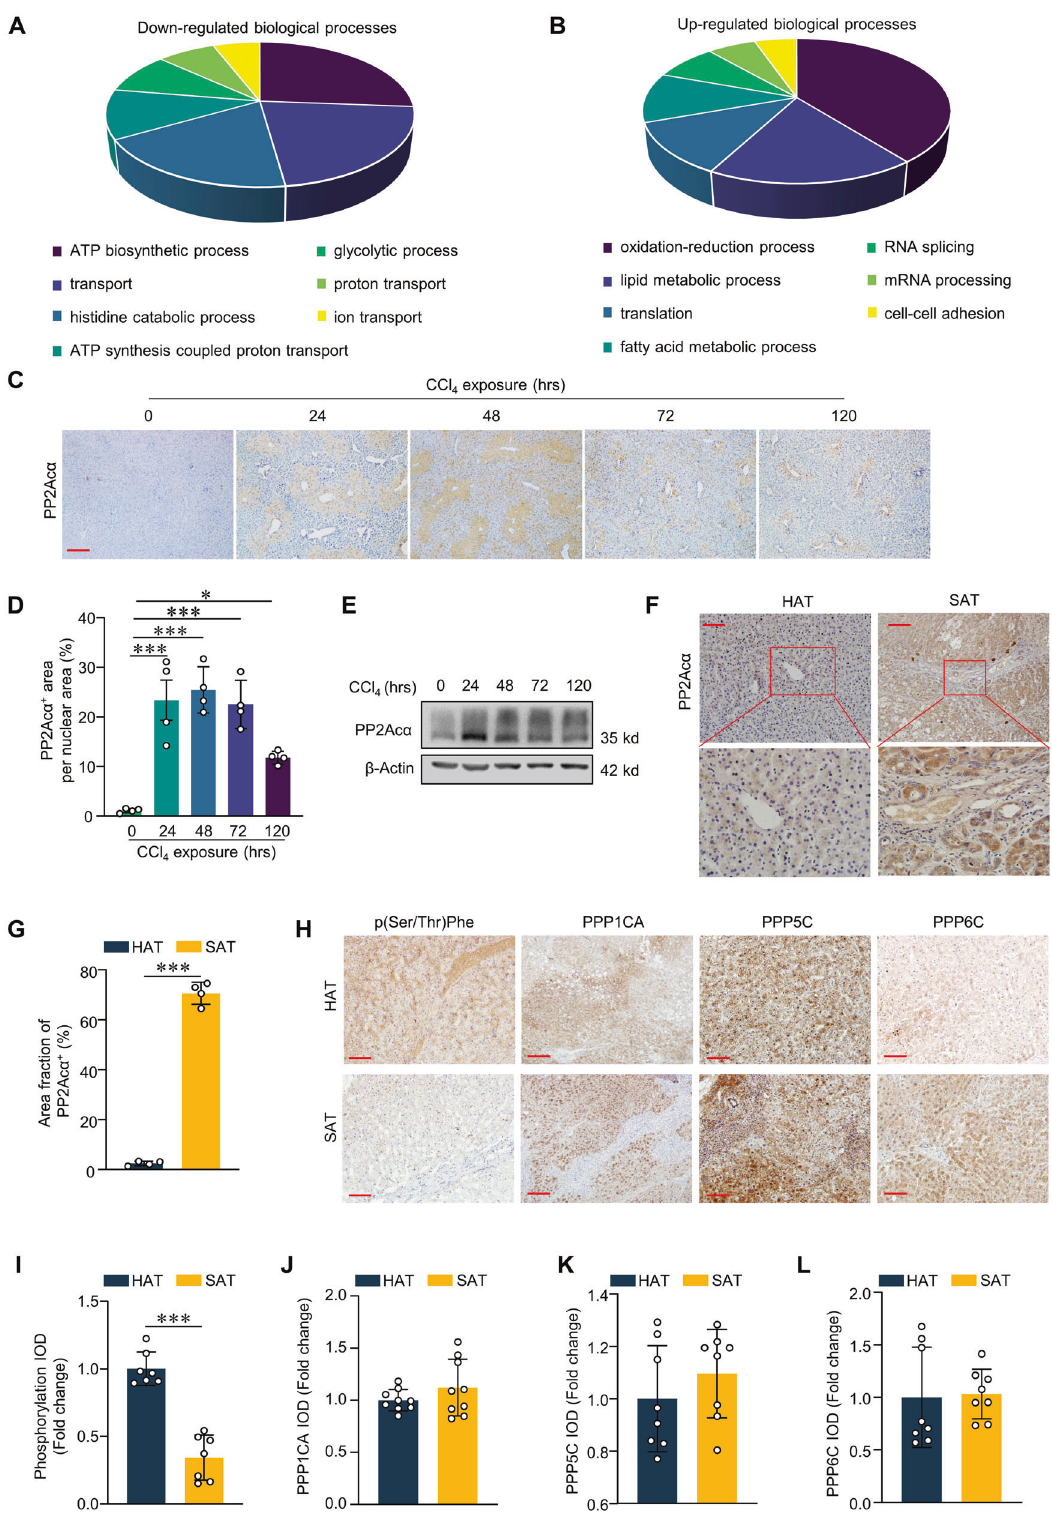
that the subacute massive necrosis samples had obviously reduced phosphorylation levels compared to the hemangioma-adjacent control tissues (Fig. 3H, I). Note that we detected no differences in the accumulation levels of other phosphatases ( e.g ., PPP1CA, PPP5C, or PPP6C) between the necrotic and control samples from